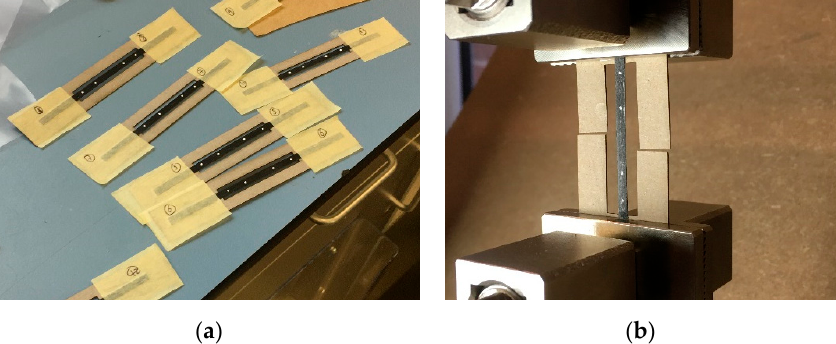
Figure 12. Tensile test samples during ( a ) preparation and ( b ) loaded in tensile test machine.